Question: Is the quantity shown trending increasing or decreasing?
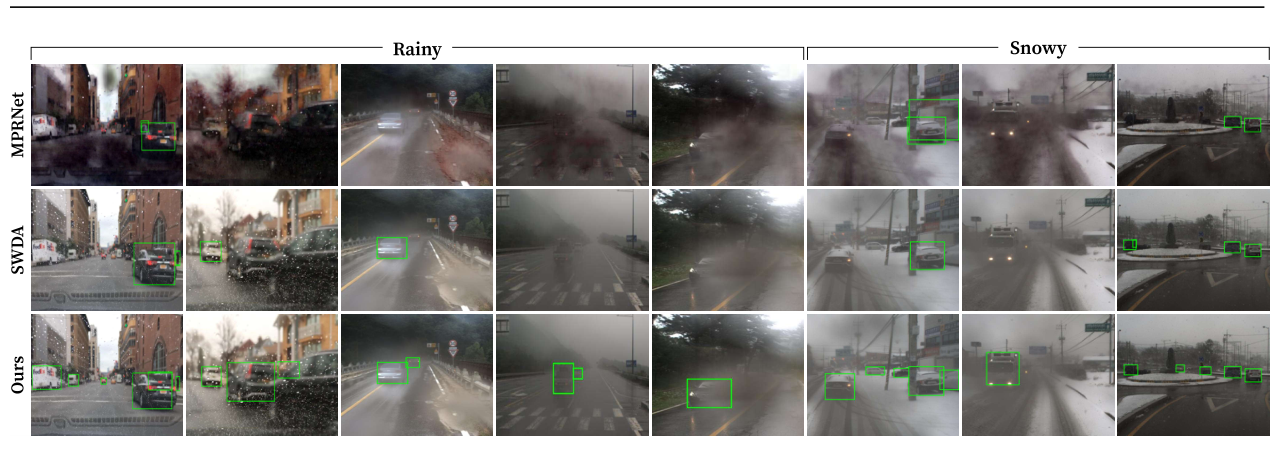
Answer: decreasing